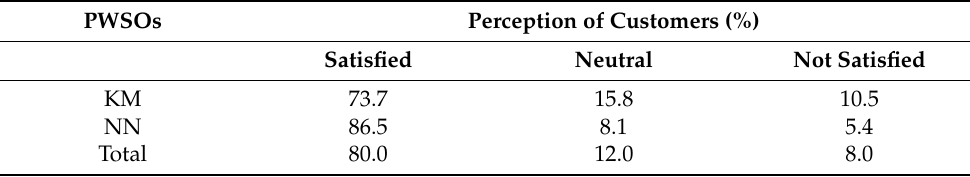
Table A2. Perception of customers on service provision of each